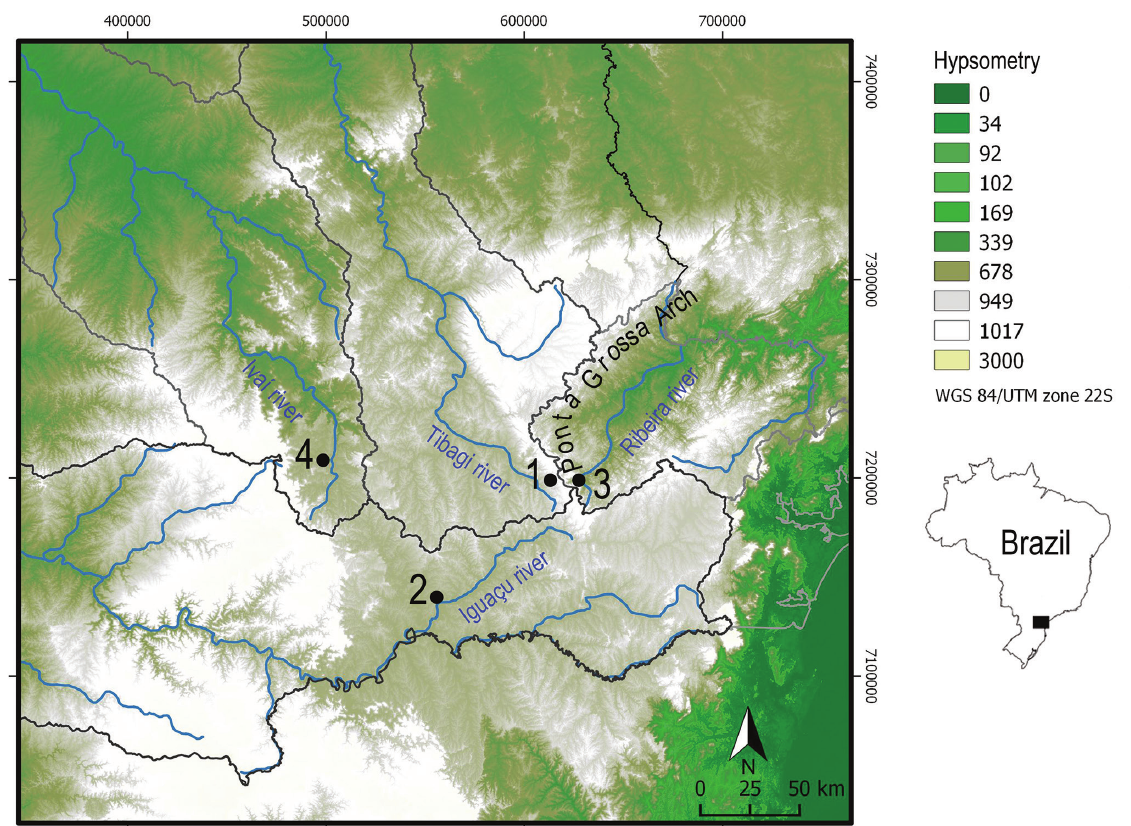
Fig. 1. Map of the Ponta Grossa Arch region in the eastern Paraná State, Brazil (inset). The map shows elevation and hydrographic basins. Details of sampled locations: (1) Verde River, Tibagi basin; (2) Iguaçu River, Iguaçu basin; (3) Areia stream, Ribeira River, Atlantic basin; and (4) Barra Grande River, Ivaí River basin. Source: Miranda